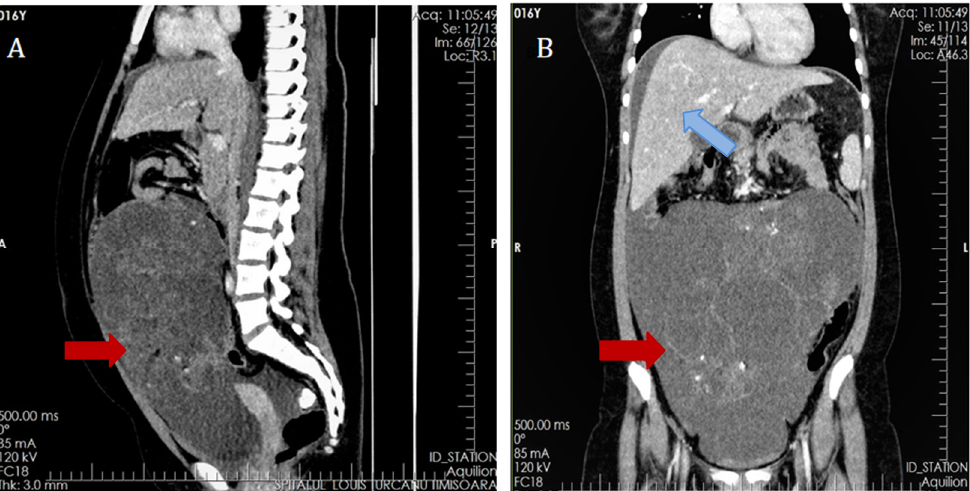
Figure 1. CT scan revealed a massive heterogeneous tumor mass of 18/13/9 (red arrow) cm with a volume of 1101 mm 3 , of pelvic origin with extension in the abdominal cavity manifesting compression on the local organs. Perihepatic ascites can be easily identified (blue arrow).